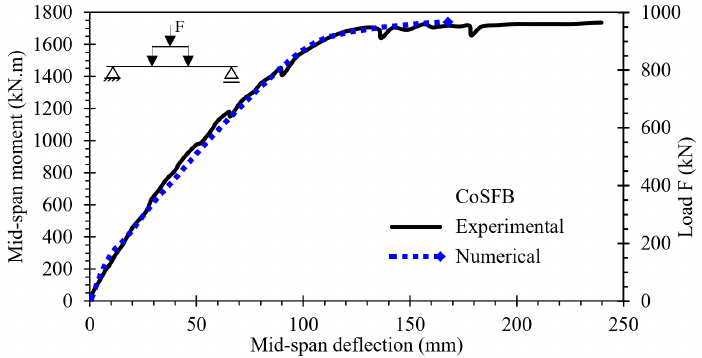
Figure 16. Composite Slim-Floor Beam